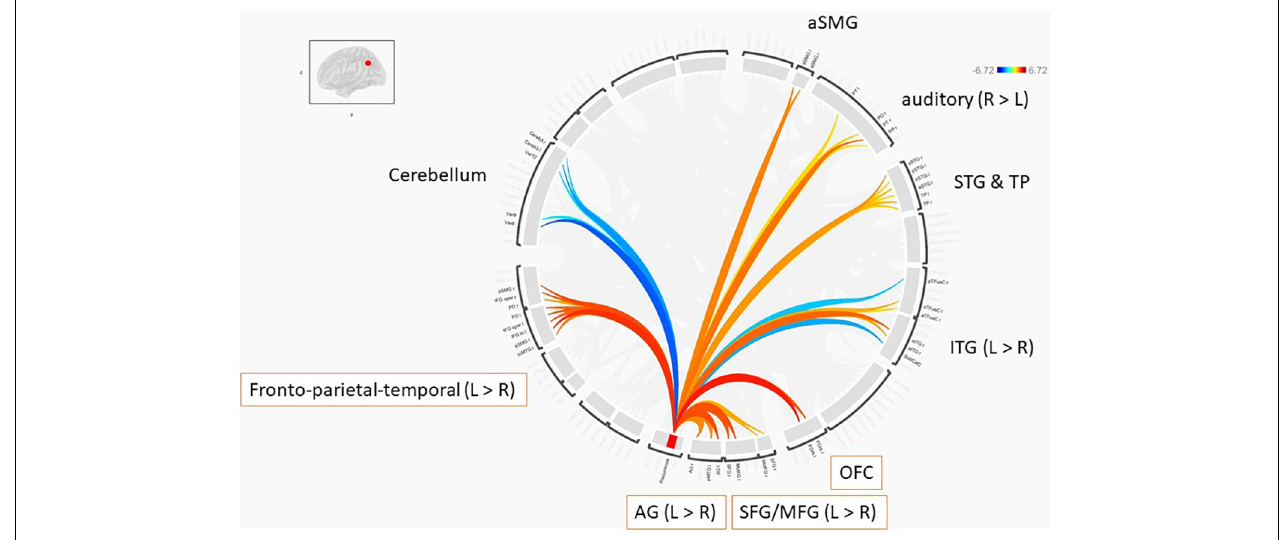
FIGURE 5 | Clustered ROI-to-ROI functional connections with significant between-condition differences based on the criteria of p -FDR <